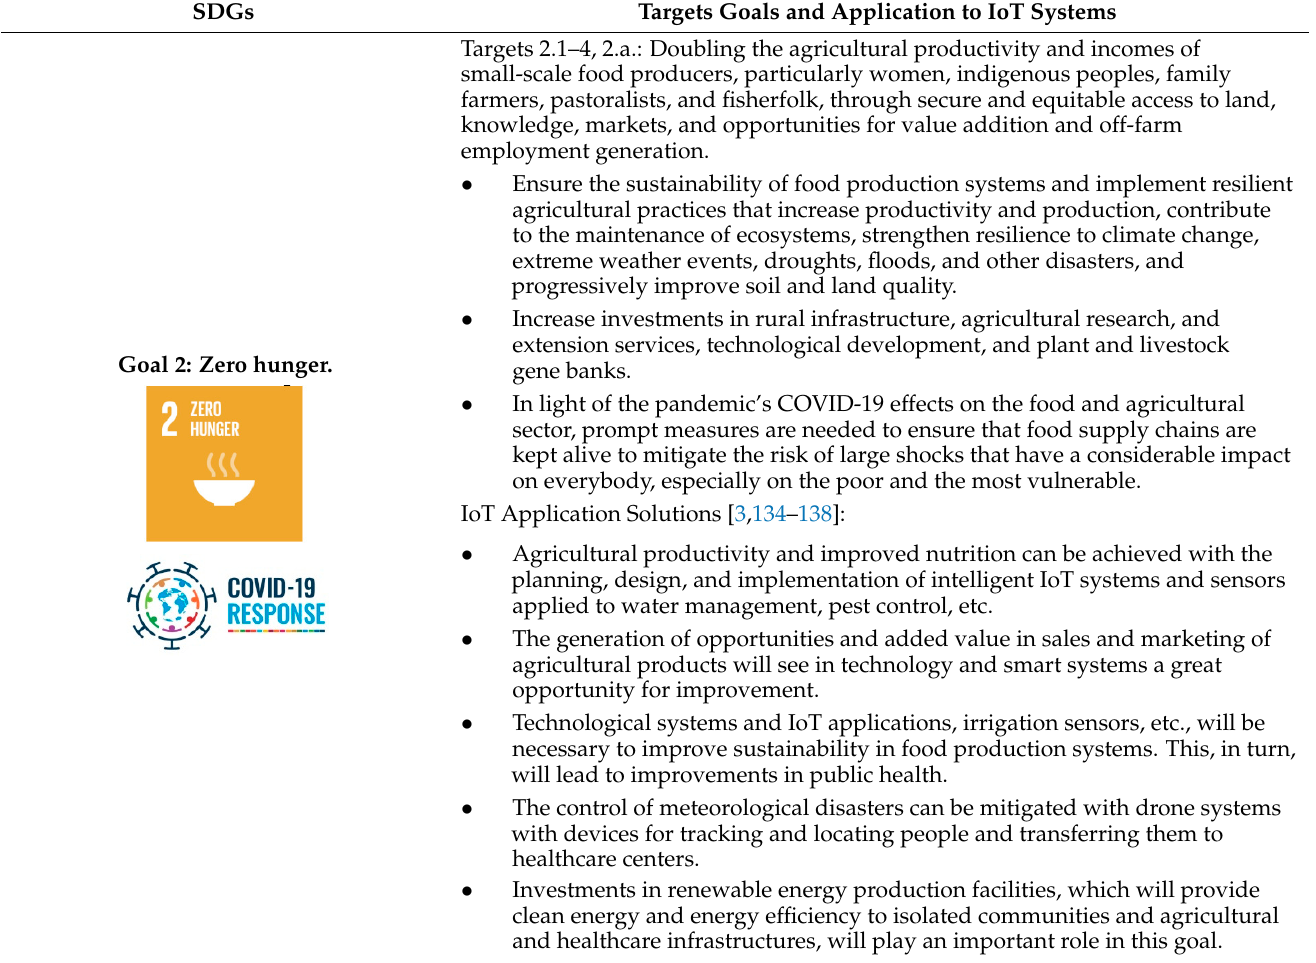
Goal 1: End poverty in all its forms